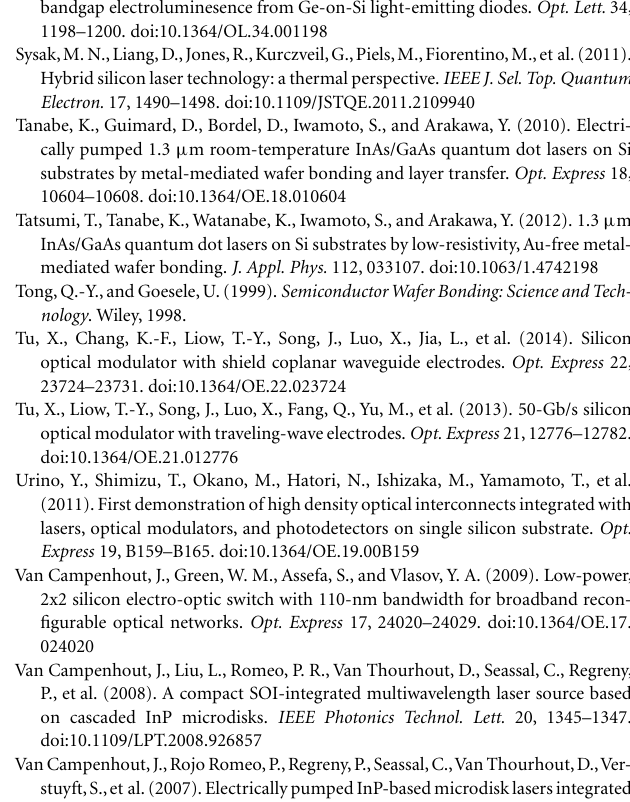
figurable optical networks. Opt. Express 17, 24020–24029. doi:10.1364/OE.17.